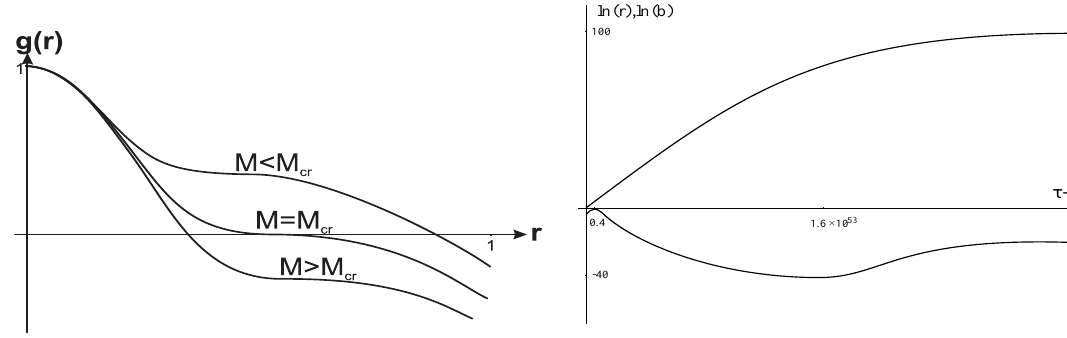
Figure 7. Evolution towards triple-horizon space-time ( left ) and evolution of scale factors ( right